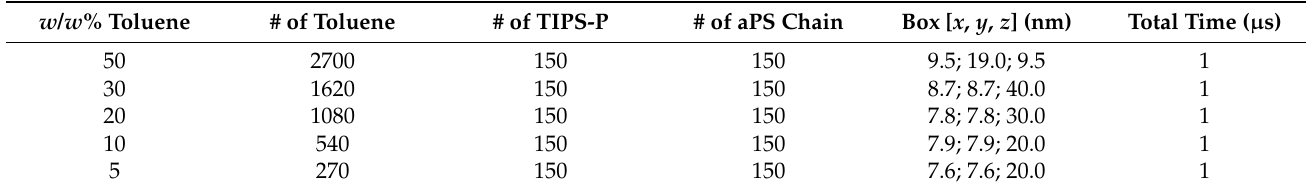
Table 1. Composition of the simulated systems.